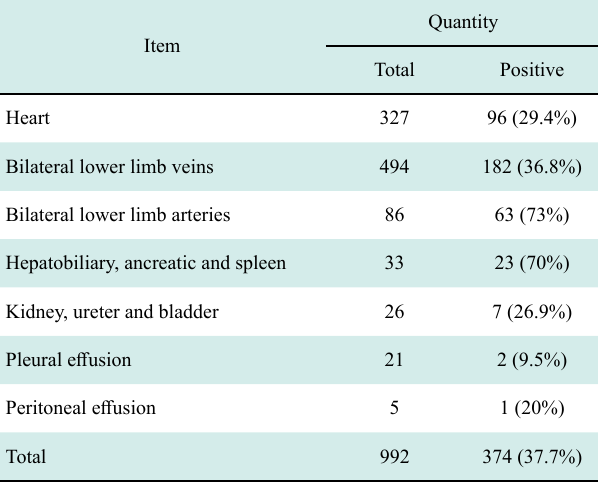
Table 2 The number positive results for other abnormalities or complications found during ultrasound examinations of COVID-19 confirmed patients